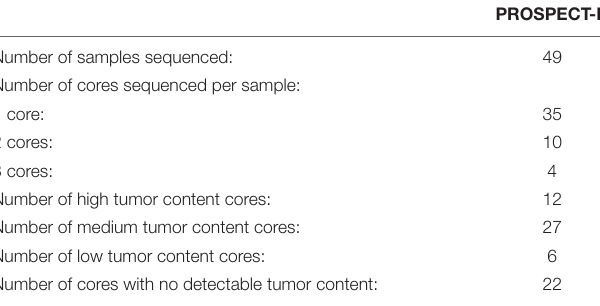
TABLE 2 | Sample tumor content estimated from Sanger